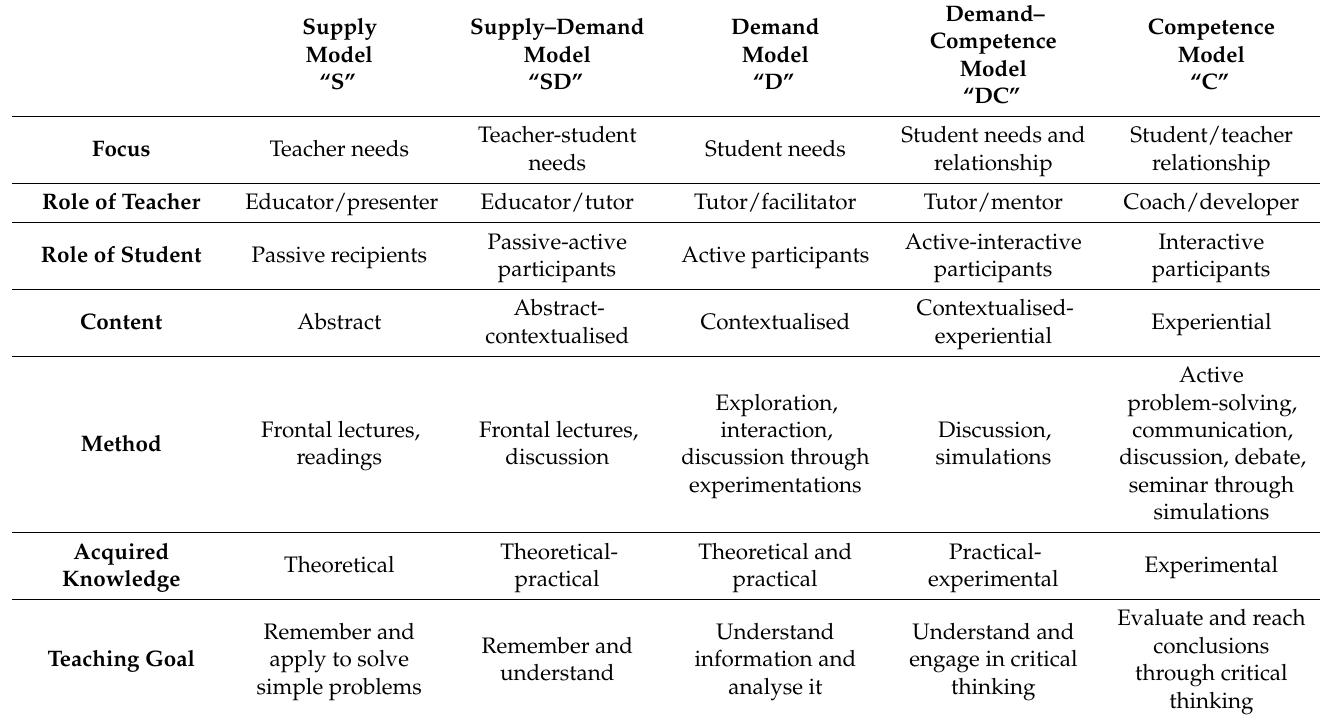
Table 2. Classification scheme and keywords for teaching